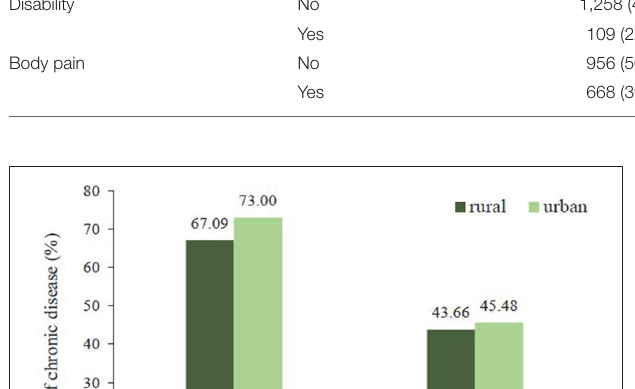
Effect of Policy on Health Outcomes Figure 2 shows that 67.09% (95% CI: 66.25, 67.93) of the rural participants had chronic diseases before the introduction of the policy and 43.66% (95% CI: 42.79, 44.53) after; meanwhile, 73.00% (95% CI: 70.41, 75.48) of the urban participants had chronic diseases before the introduction of the policy and 45.48% (95% CI: 43.46, 47.50) after. Table 5 shows the multivariate analysis of the effect of the URRBMI policy on health outcomes by the GLMM. Compared to before the introduction of the policy in the urban population in model 1, the risk of having chronic diseases decreased by 70% (OR = 0.30; 95% CI: 0.26, 0.35) after the policy had been implemented; in the rural participants, the risk of having chronic diseases was 22% lower (OR = 0.78; 95% CI: 0.67, 0.90) than the risk in the urban participants prior to the policy and 71% lower (OR = 0.29; 95% CI: 0.25, 0.33) after. The differences